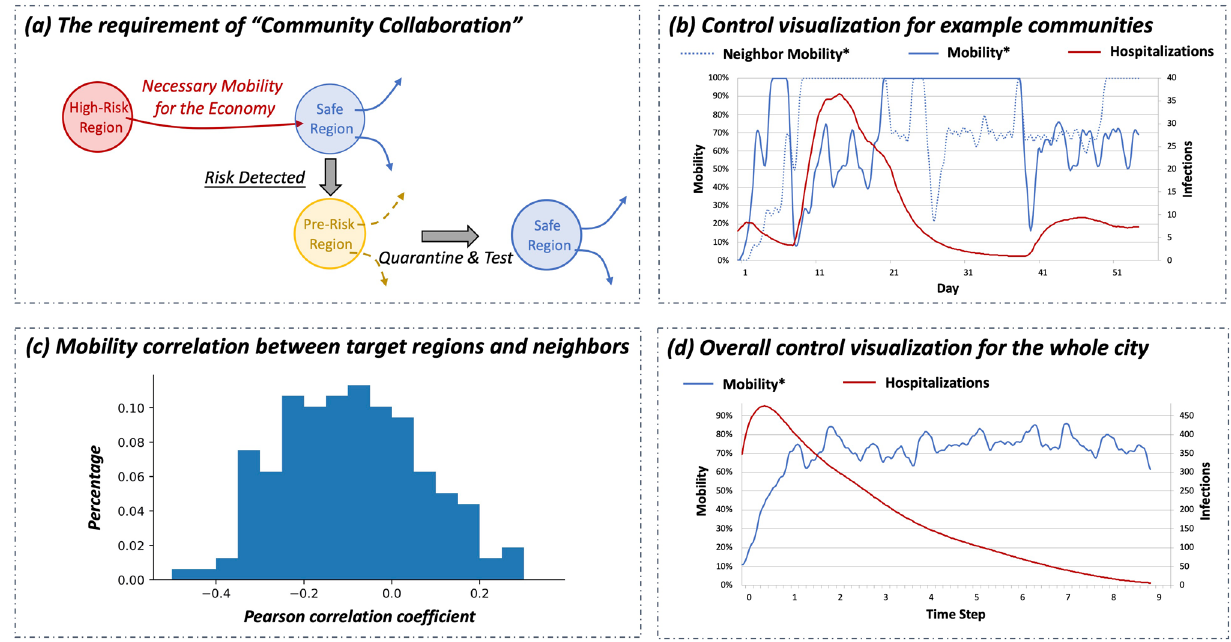
Figure 4. Ideally executing community quarantine and route management requires “community collaboration”. ( a ) Intuitive explanation. ( b ) The control extents and pandemic statistics of example communities; one community would accept risky mobility from another community to relieve its lockdown pressure; in the meantime, it would lock itself down to prevent further pandemic spread. ( c ) The Pearson correlation coefficient between the mobility of every region and its collaborative neighbor; for the example two communities, the coefficient is − 0.28 . ( d ) The overall control extents and pandemic statistics of the city.